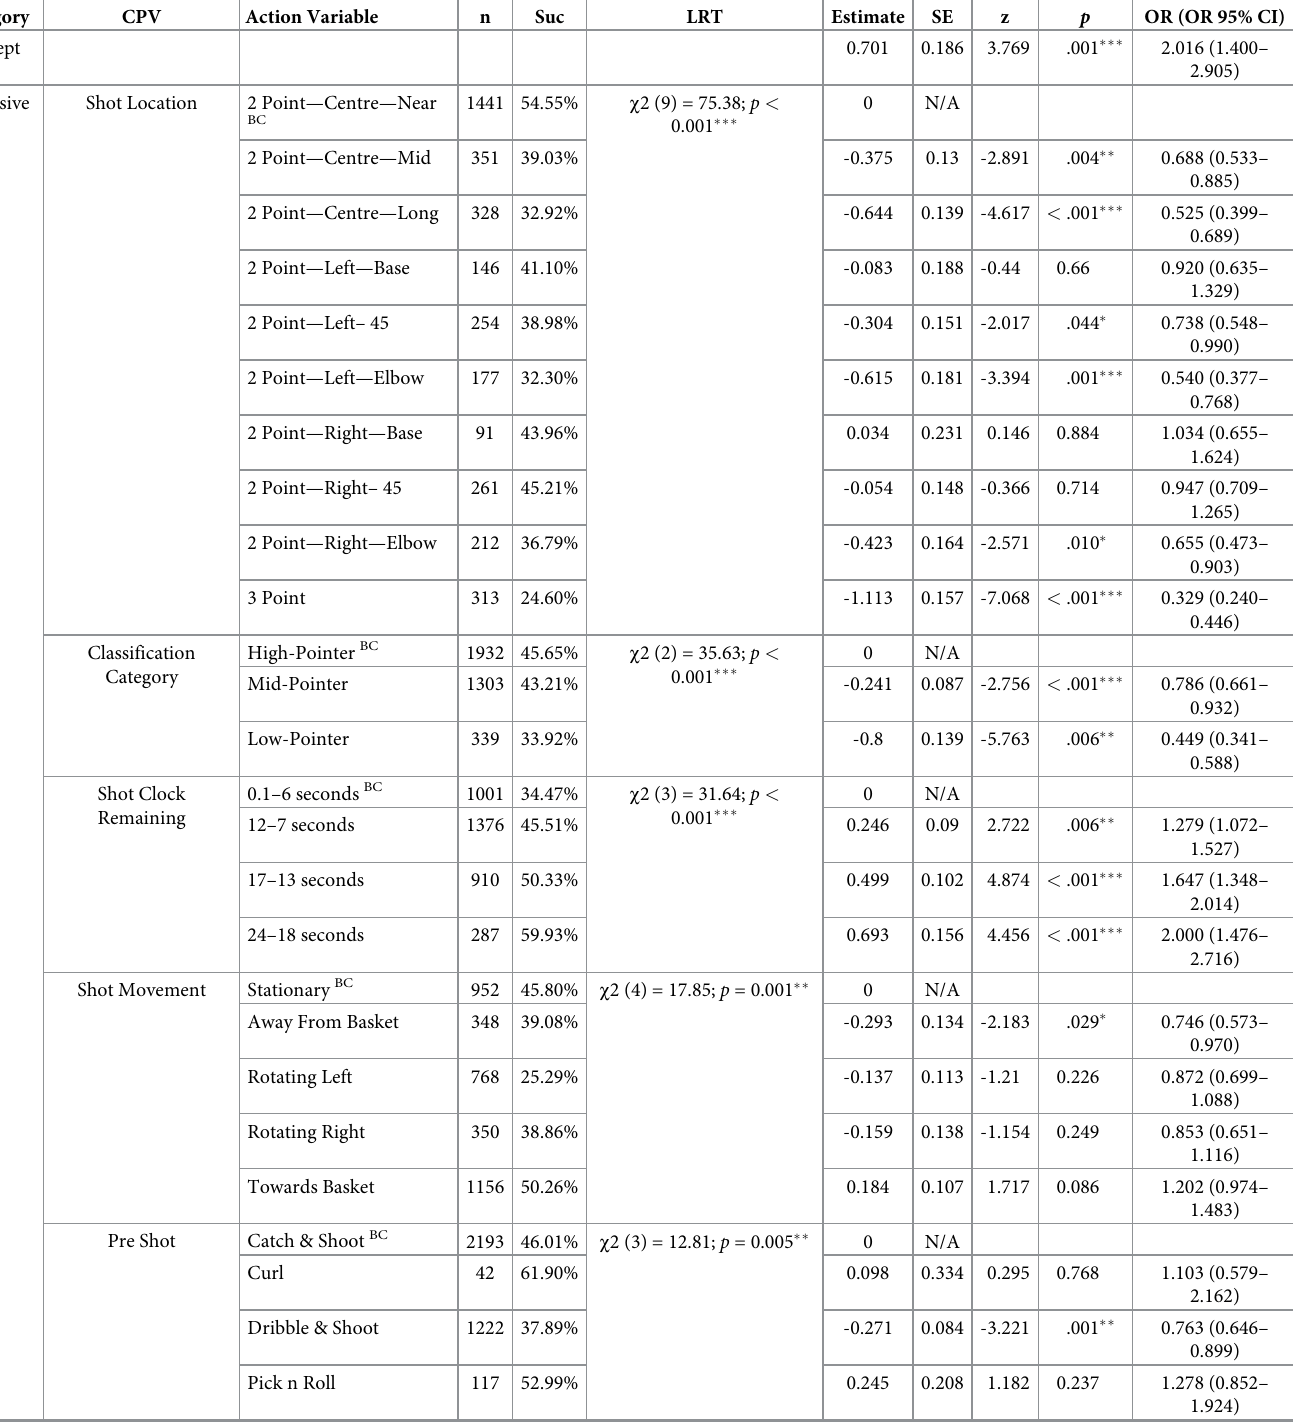
Table 4. Final model illustrating the frequency counts (n) and percentage success (Suc) from the 70% sample (3,574 field-goal attempts), likelihood ratio test (LRT) values, estimated regression coefficients, standard errors, p-values and ORs for the intercept variable and each action variable within a CPV.